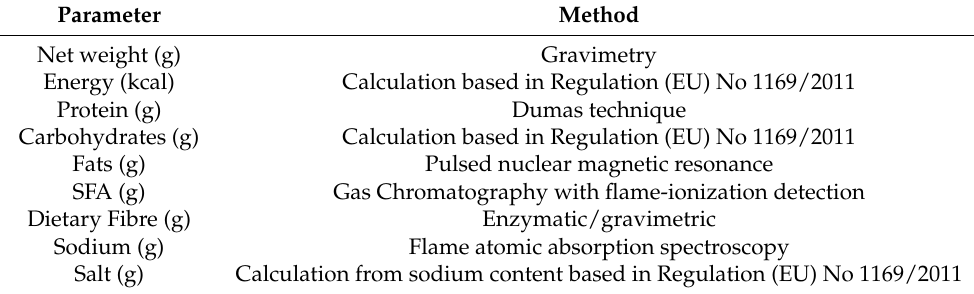
Table 1. Analytical